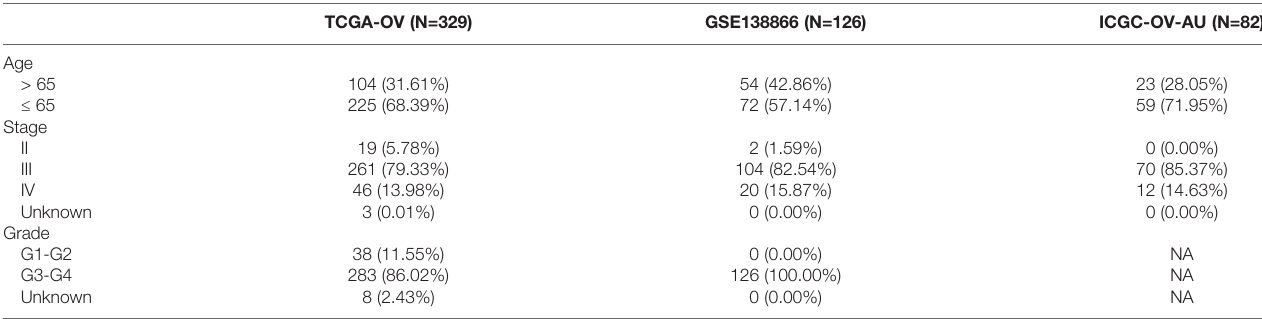
TABLE 3 | Patient